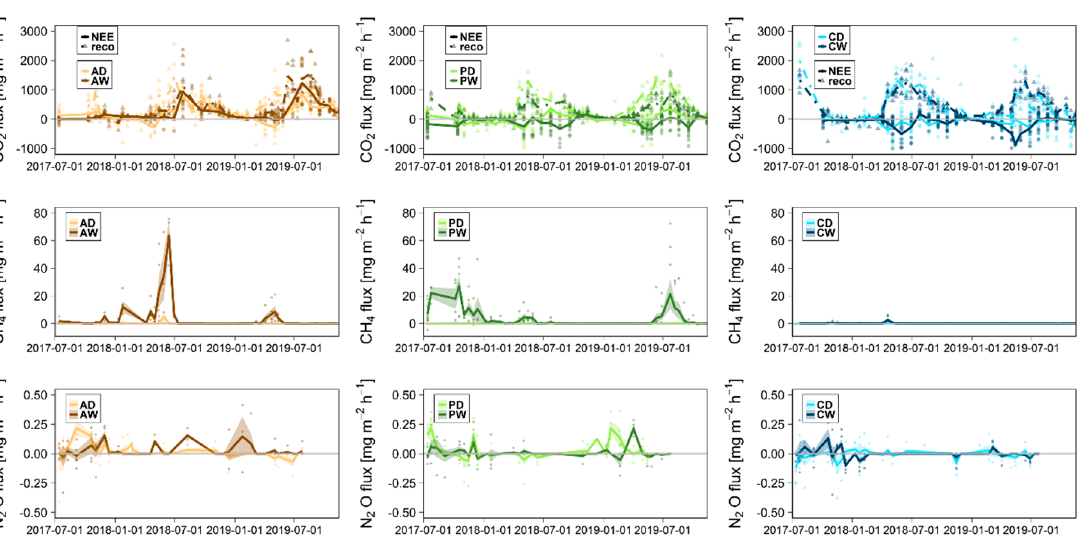
Figure 10. Relationships between soil hydraulic variables as derived from extensive meta-analysis of the literature (black) and from our own measurements in the WETSCAPES study sites: ( a ) Porosity vs. bulk density with separation of micropores (squares) and total pores (circles); ( b ) Saturated hydraulic conductivity (K s ) vs. bulk density. For details on data acquisition and analysis, see [113].